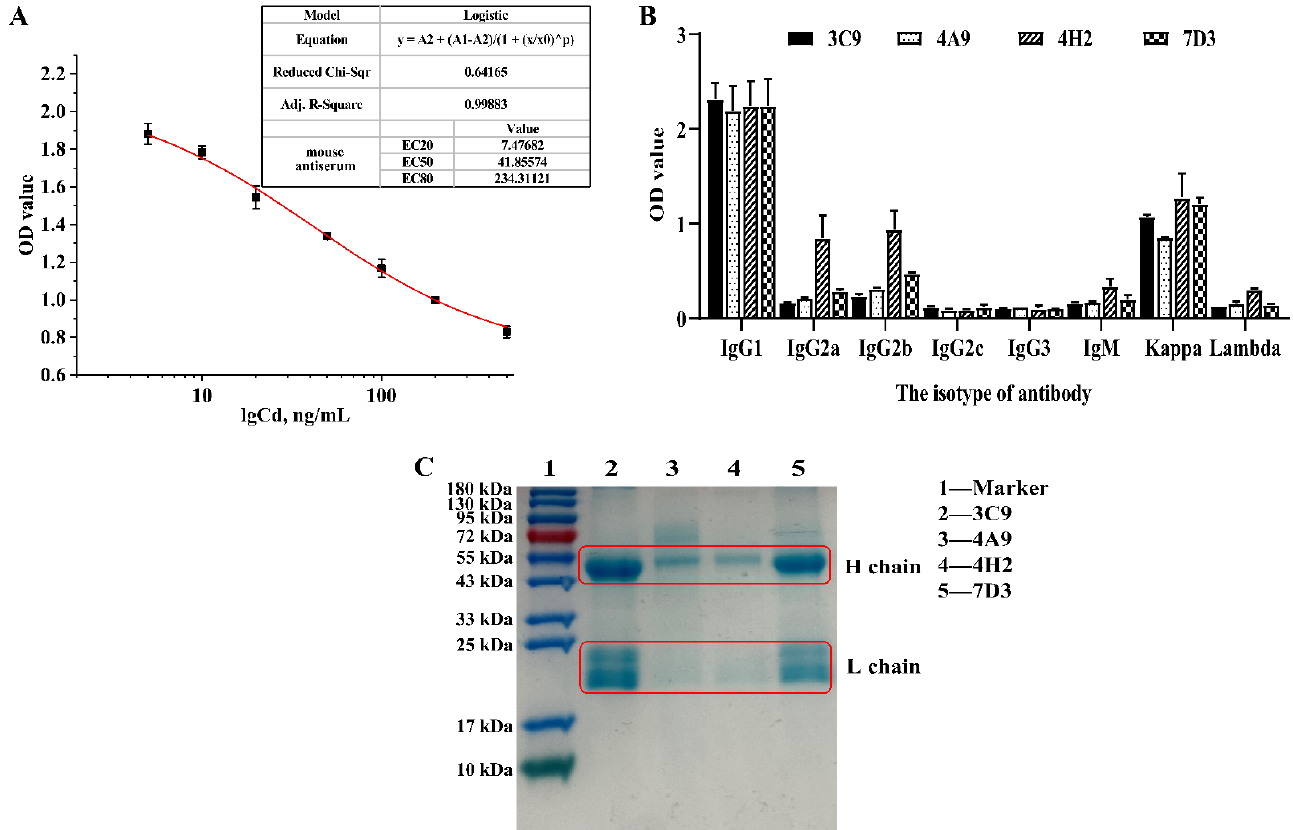
Figure 4. Identification of positive hybridoma cells. ( A ) Standard curve of antiserum obtained after final immunization against immunogen Cd-ITCBE-BSA30 in BALB/c mice. ( B ) Identification of antibody isotype secreted by different cell lines; ( C ) Analysis of the purity of antibodies secreted by different cell lines.